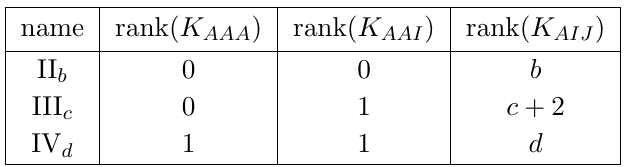
Table 5 . This table list the conditions on N A ; (cid:17) given in (3.21) and (3.23) that ensure a